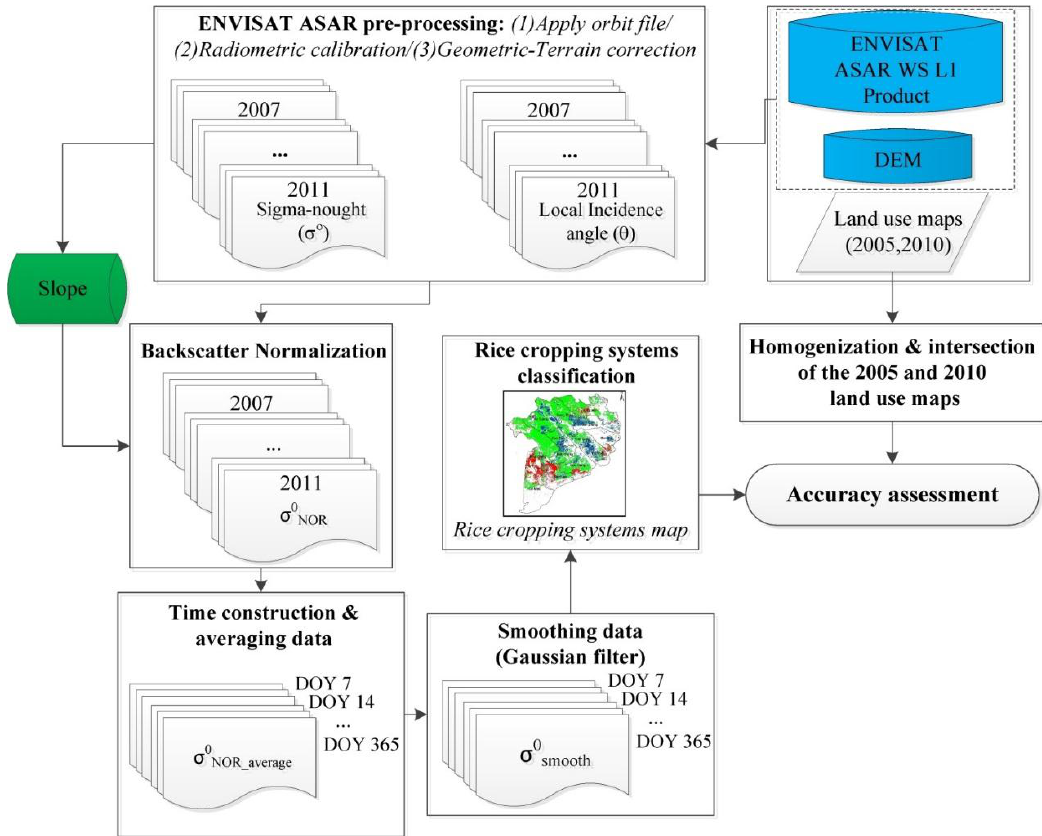
Figure 4. ENVISAT ASAR data analysis, rice classification, and validation steps.